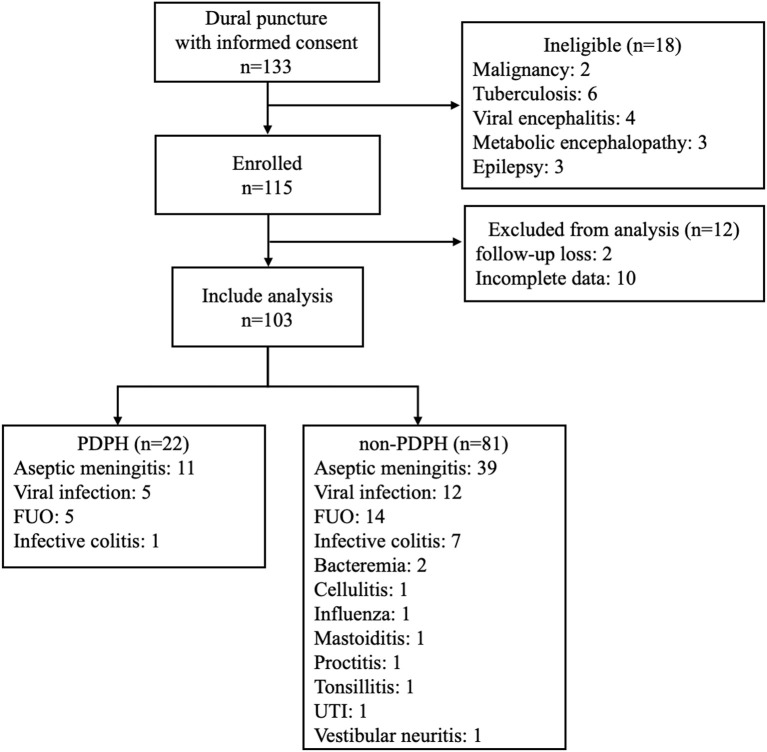
Flow chart of participants included in this study.